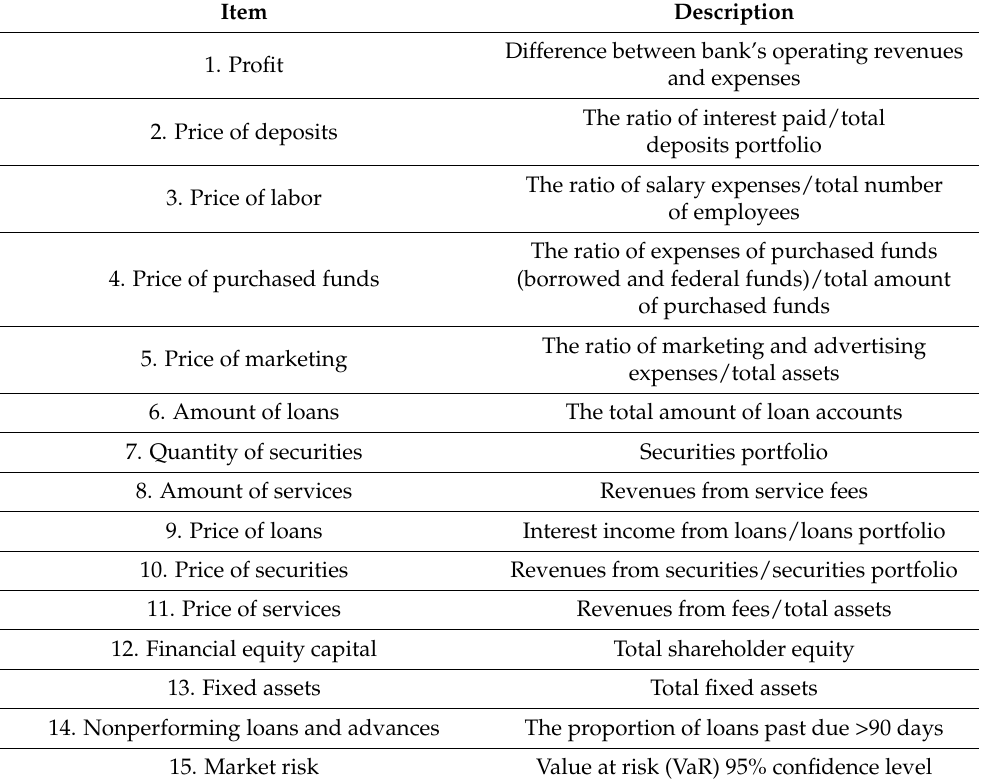
Table 2. Description of items for profit